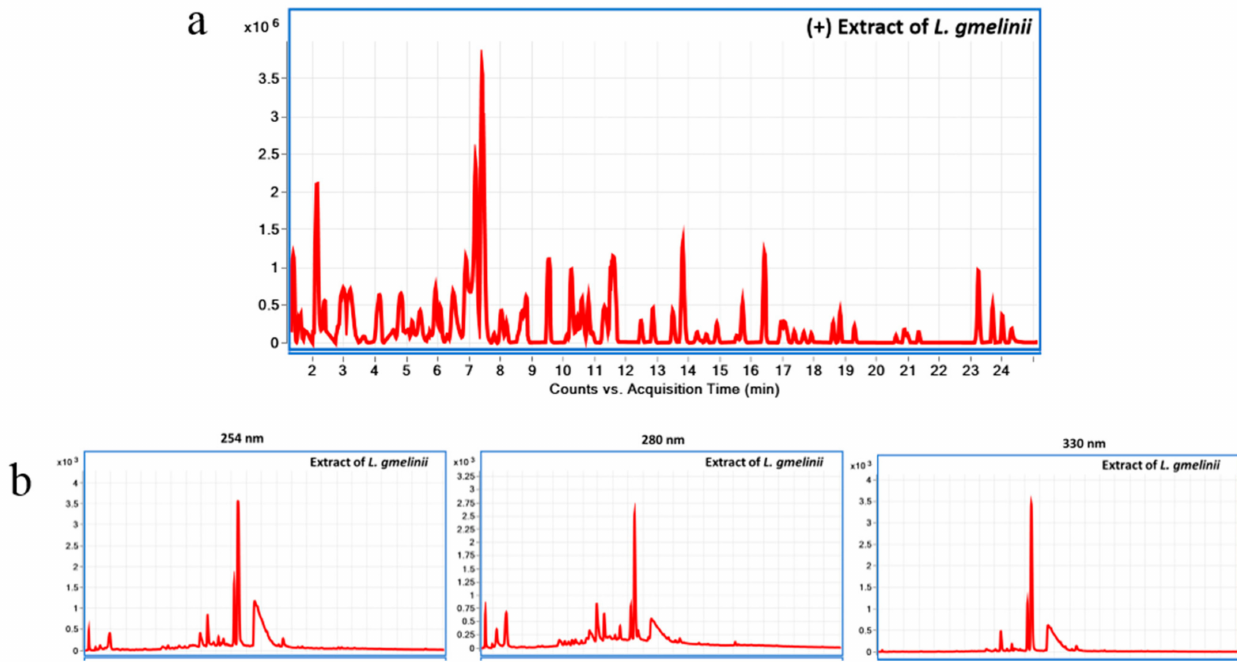
Figure 1. Chemical characterization of L. gmelinii root extract using Liquid chromatography diode array detector-quadrupole time-of-flight mass spectrometry (LC-DAD-QToF). LC-MS chromatogram of L. gmelinii extract in (+)ESI mode using LC-QToF ( a ); LC-UV chromatogram of L. gmelinii extract at 254, 280, and 330 nm using LC-DAD ( b